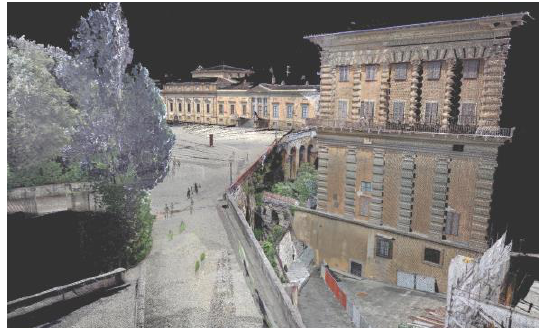
Figure 5. Point cloud, general view of the garden and the Piazzale della Meridiana